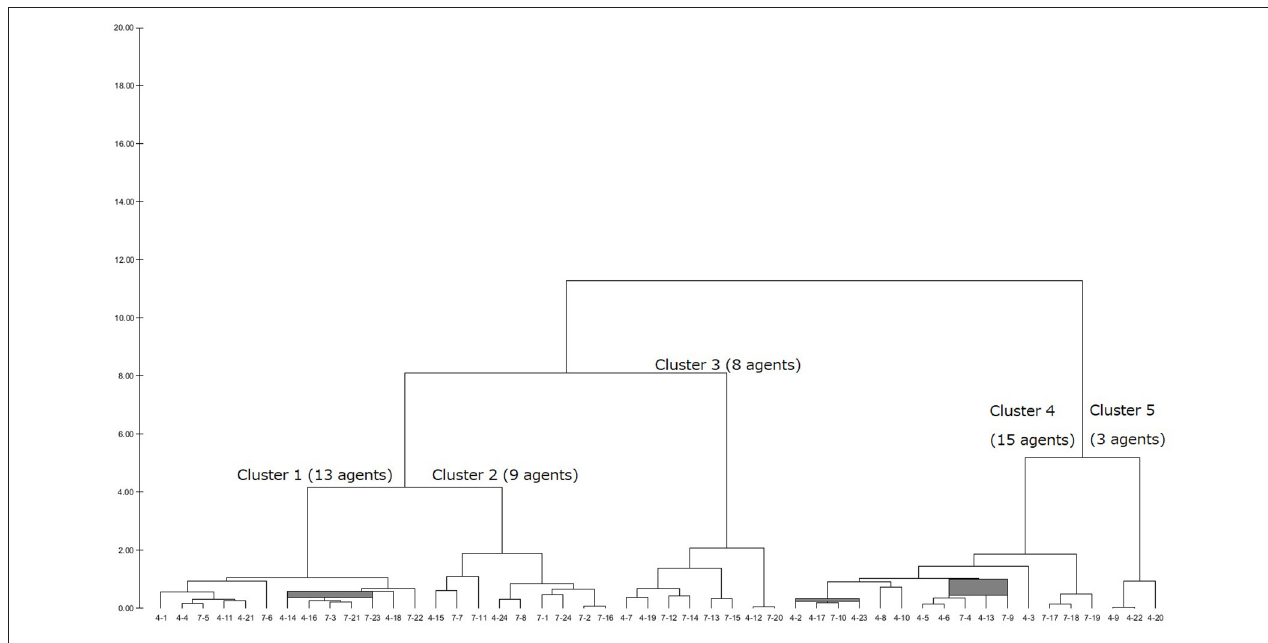
FIGURE 3 | Generated dendrogram (LUIG43).